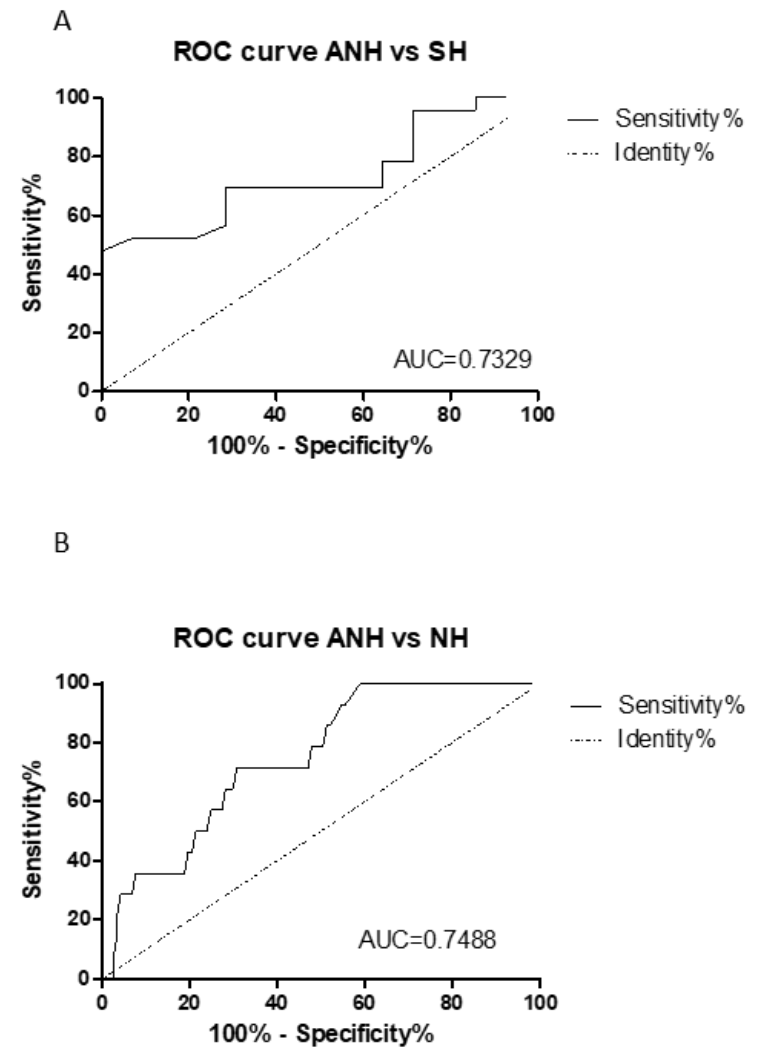
Figure 2. ROC curve analysis ( A ) ANH and SH; ( B ) ANH and NH.